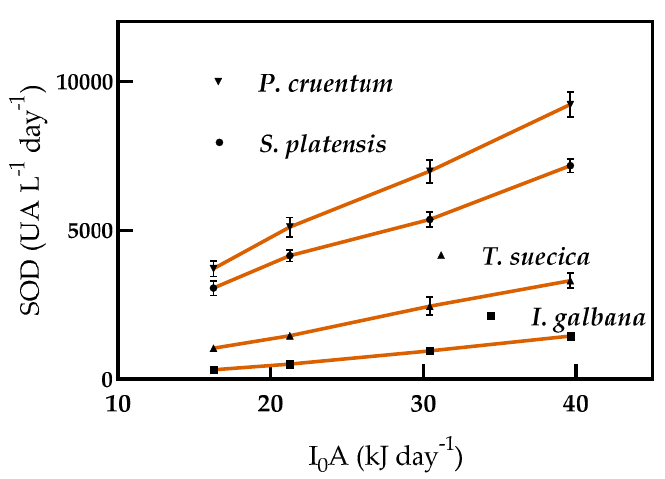
Figure 8. SOD productivity by S . platensis , I . galbana , T . suecica , and P . cruentum in continuous culture with different supplied light intensities. Each point indicates the mean of 3 replicates ( p < 0.05). Table 10. PC and APC accumulation in S . platensis and P . cruentum in continuous cultures at different supplied light intensities.